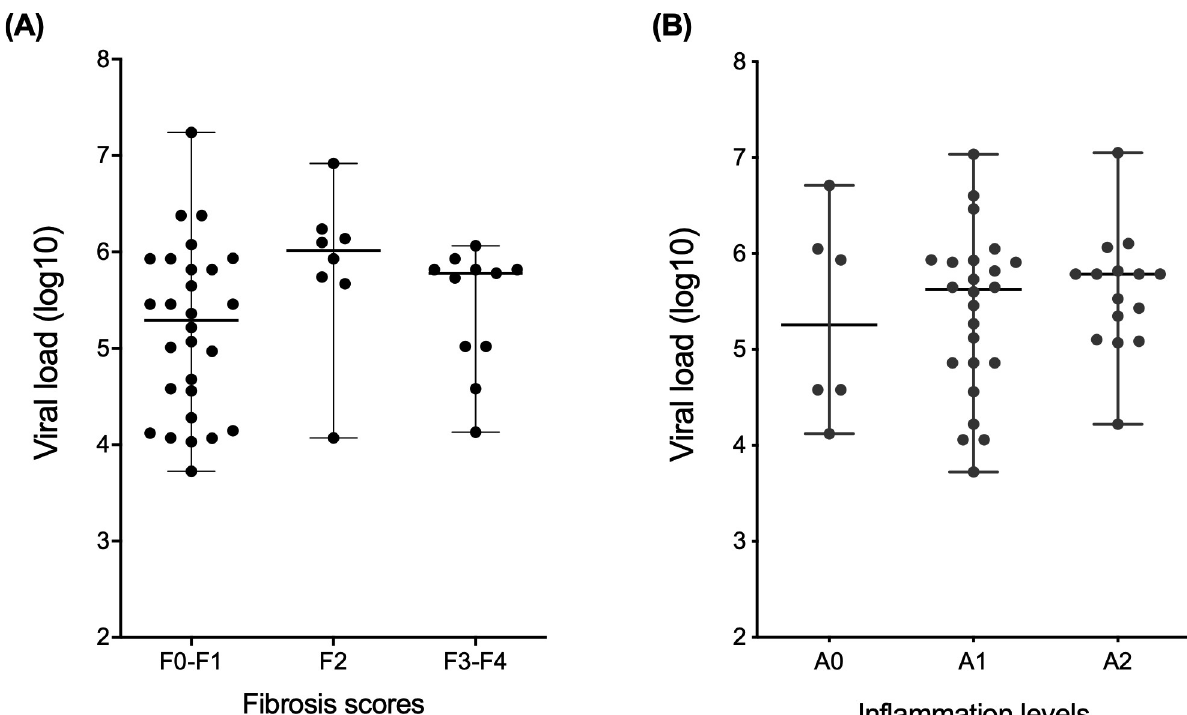
Fig 2. HCV viral load according to the clinical condition of the liver. A-B: Comparison of the median plasma viral load in chronic viral hepatitis patients with different fibrosis scores and with necroinflammatory activity scores (METAVIR) in the liver. Kruskal-Wallis test.